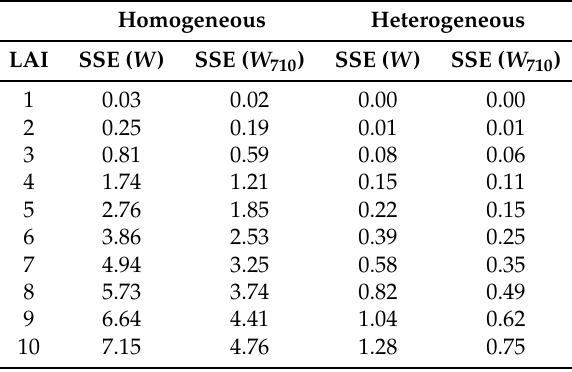
Figure 6. Dependence of a , p and DASF with LAI for for homogeneous ( left panel ) and heterogeneous ( right panel ) canopies. Table 3. SSE values between W and W 710 for LAI 1–10 in homogeneous (HOM25) and heterogeneous (HET12)